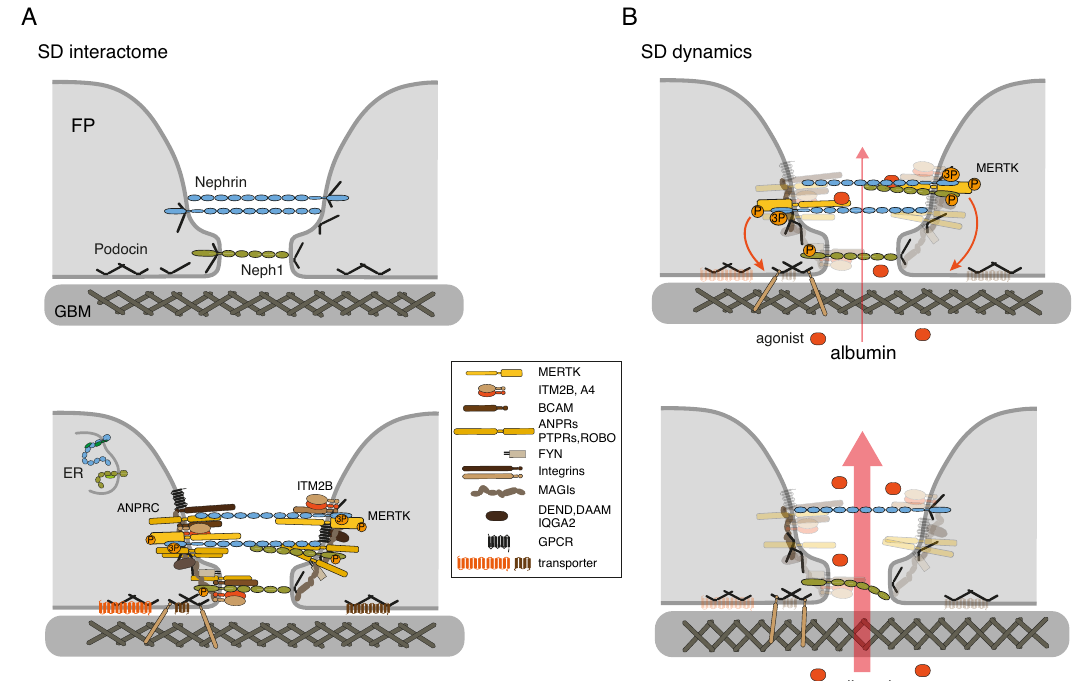
Fig. 5 | Complexity of SD subunit composition and principle of context- dependent dynamics endowed by the associated network of proteins. A Schematic representation of the hypothetical molecular appearance of the rodent SD before (upper panel; Grahammer et al. 7 ) and after interactome analysis (lower panel). Protein constituents are drawn about to scale (using data from lit- erature and databases, as well as from AlphaFold 59 ), and illustration was restricted to structurally distinct constituents (legend on the right) to highlight the com- plexityoftheSDandtheassociatedproteinnetwork.Sitesandorderofinteraction,